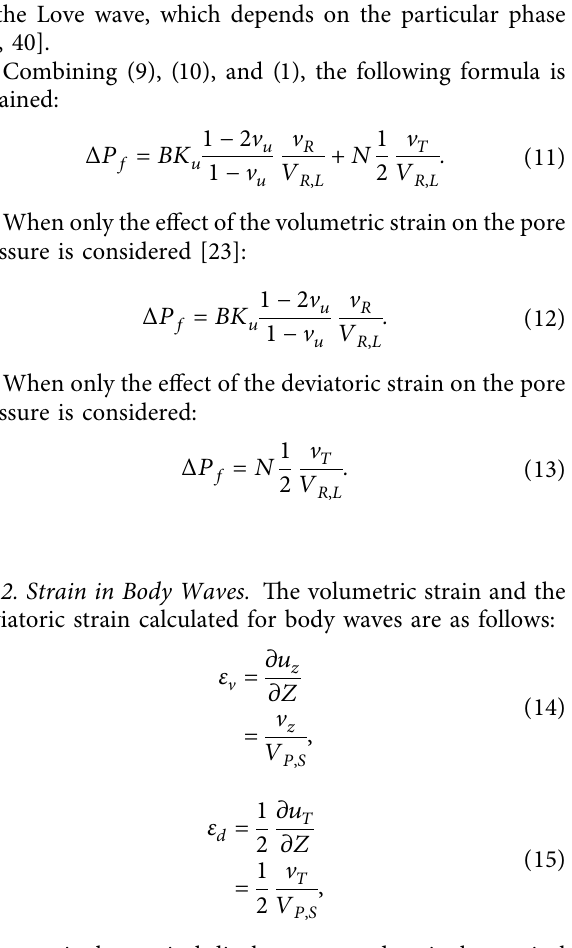
� 3.197 GPa and N � 2.238 GPa with (Figure 3(g)) and BK u R 2 � 0.201 for the Kaik � oura earthquake (Figure 3(h)). The amplitude during the P and S periods was small, and